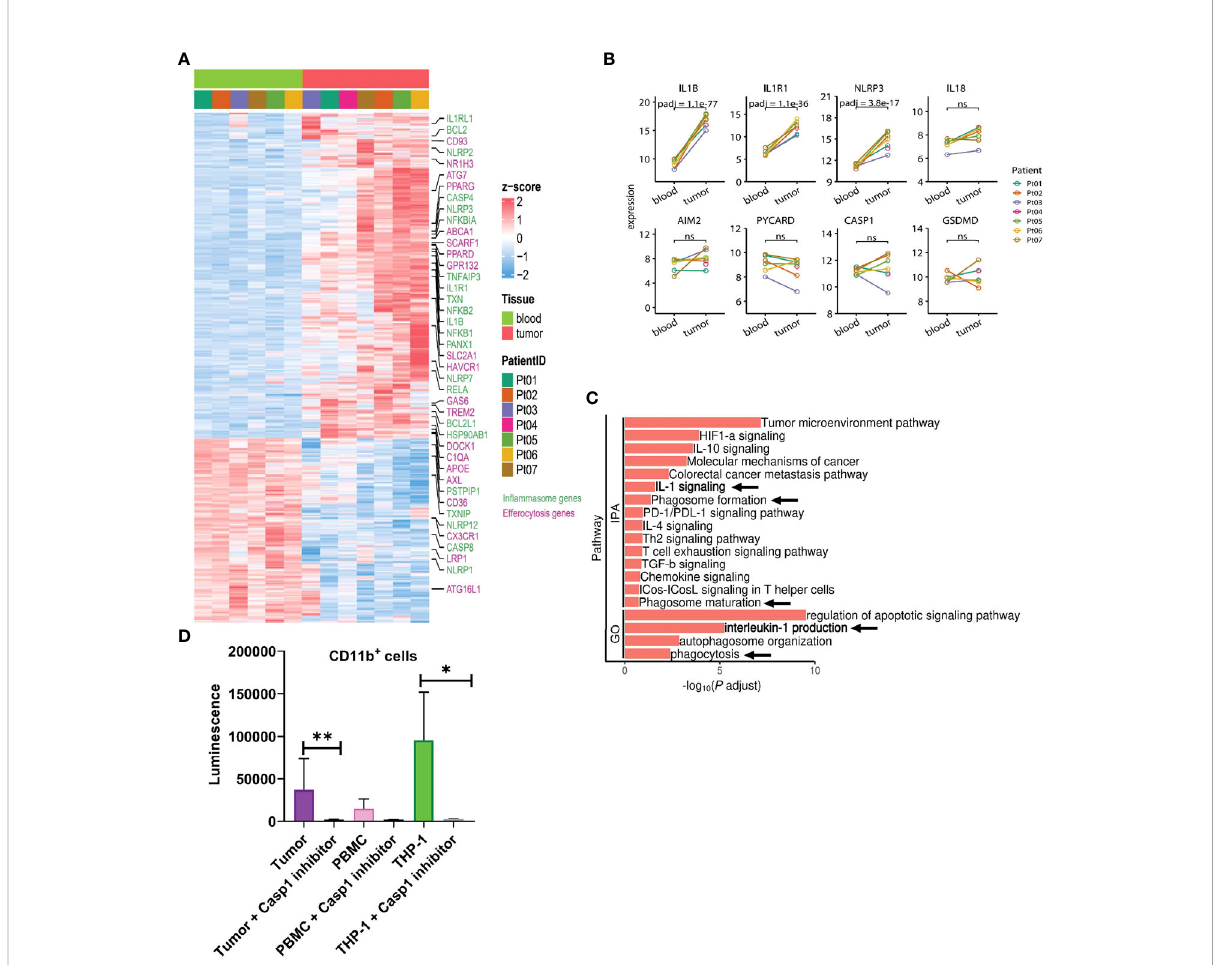
FIGURE 3 IL-1 b signaling pathways are enriched in tumor in fi ltrating myeloid cells in human HNSCC. (A) Heatmap showing differential gene expression pro fi le between CD11b + myeloid cells fl ow sorted from matched blood or tumor from 7 HNSCC patients as measured by bulk RNA-seq. (B) Differential in fl ammasome signature in tumor and blood myeloid cells (n=7). (C) Ingenuity pathway (IPA) and gene ontology (GO) analyses showing enrichment of IL-1 signaling in tumor in fi ltrating myeloid cells over those from blood. (D) Caspase 1 activity is upregulated in tumor in fi ltrating CD11b + myeloid cells compared to circulating blood CD11b + cells (n=3). Statistics represent paired t-test and error bars represent SD (D). (*p < 0.05, **p < 0.01; ns, not signi fi